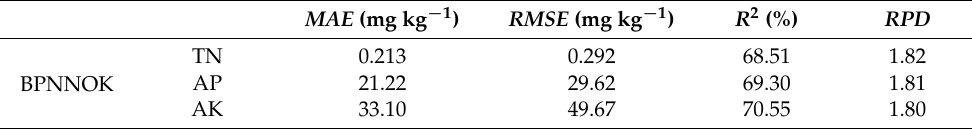
Figure 6. Predictive maps of ( a ) soil TN; ( b ) soil AP; and ( c ) soil AK using BPNNOK model in 100 m × 100 m resolution. Table 7. The predictive accuracy of soil nutrient contents using BPNNOK model at the validation set.